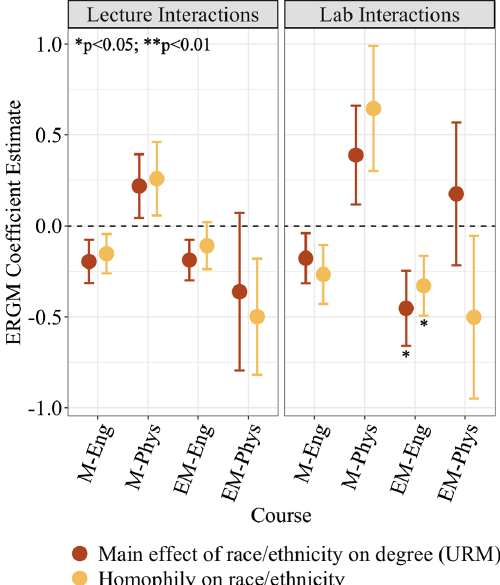
FIG. 6. Plot of ERGM coefficients for the two predictor variables related to gender. A more positive (negative) coefficient estimate for the main effect of gender on degree variable indicates that women have more (fewer) connections than men. A more positive (negative) coefficient estimate for the homophily on gender variable indicates that more (fewer) edges occur between students of the same gender. Error bars indicate the standard error for each estimate and asterisks indicate statistical significance.